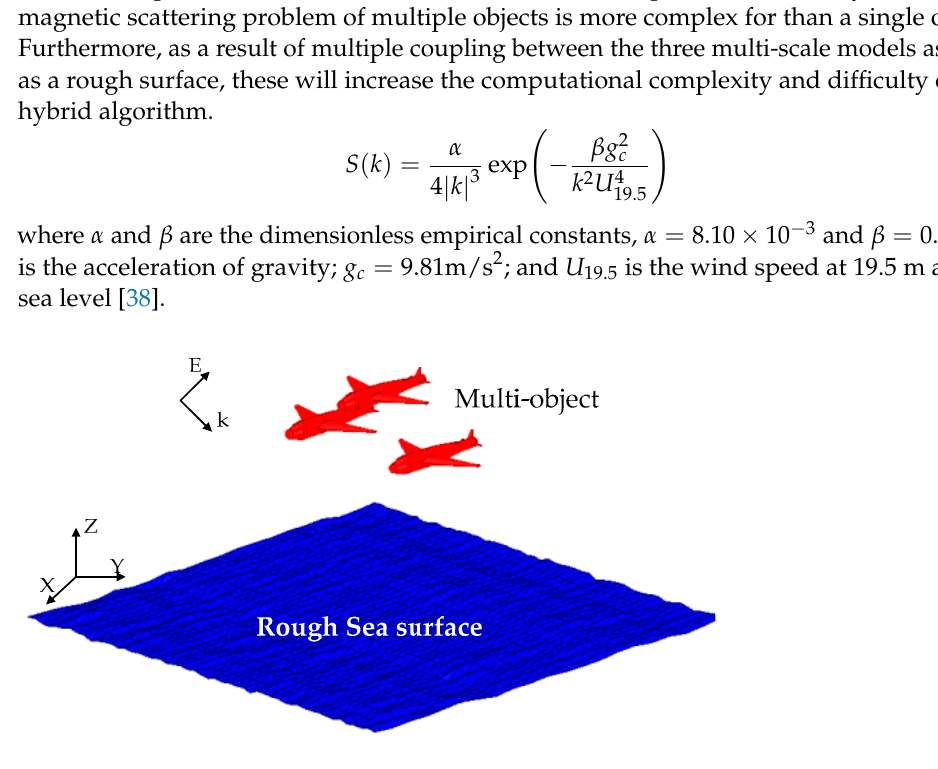
Figure 12. The multi-object-rough sea surface composite object.